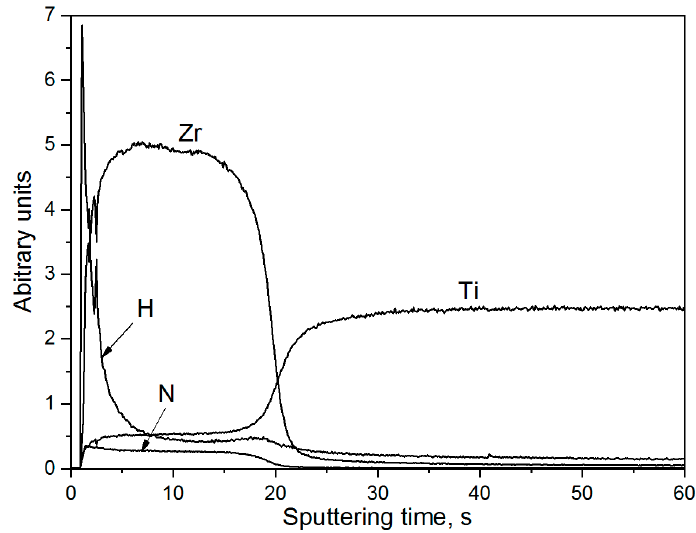
Figure 5. Element distribution profiles in the TZ2SMC specimens of the Ti0.16Pd alloy with a δ — (Ti,Zr)N coating (ratio Zr/Ti = 1.28) immediately after cathode hydrogenation in a physiological saline solution.